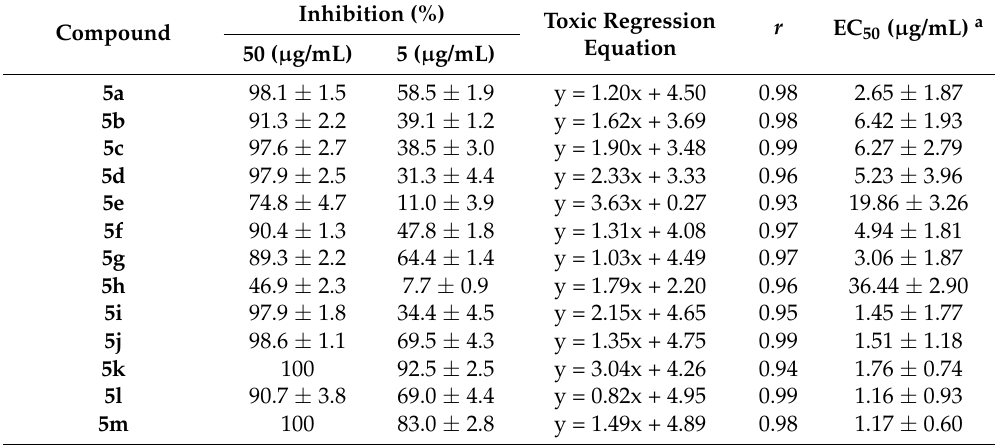
Table 2. Antibacterial activity of the target compounds against Xoc in vitro.